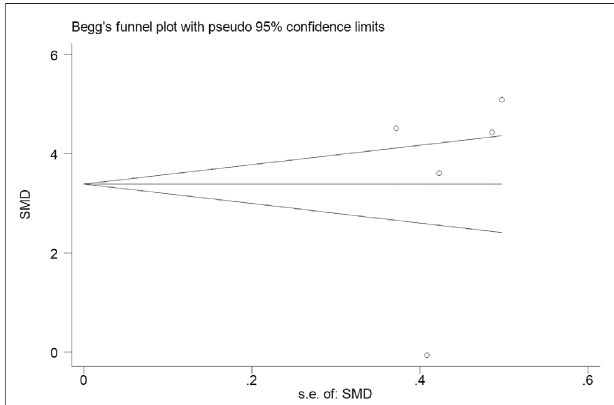
FIGURE5| FunnelplotofstudiesbyStatafor fi vestudiesincludedinthe meta-analysis. No obvious publication bias was found in the meta-analysis on thechangesofserumCRPlevelinchildhoodepilepsytreatedbylevetiracetam ( p =